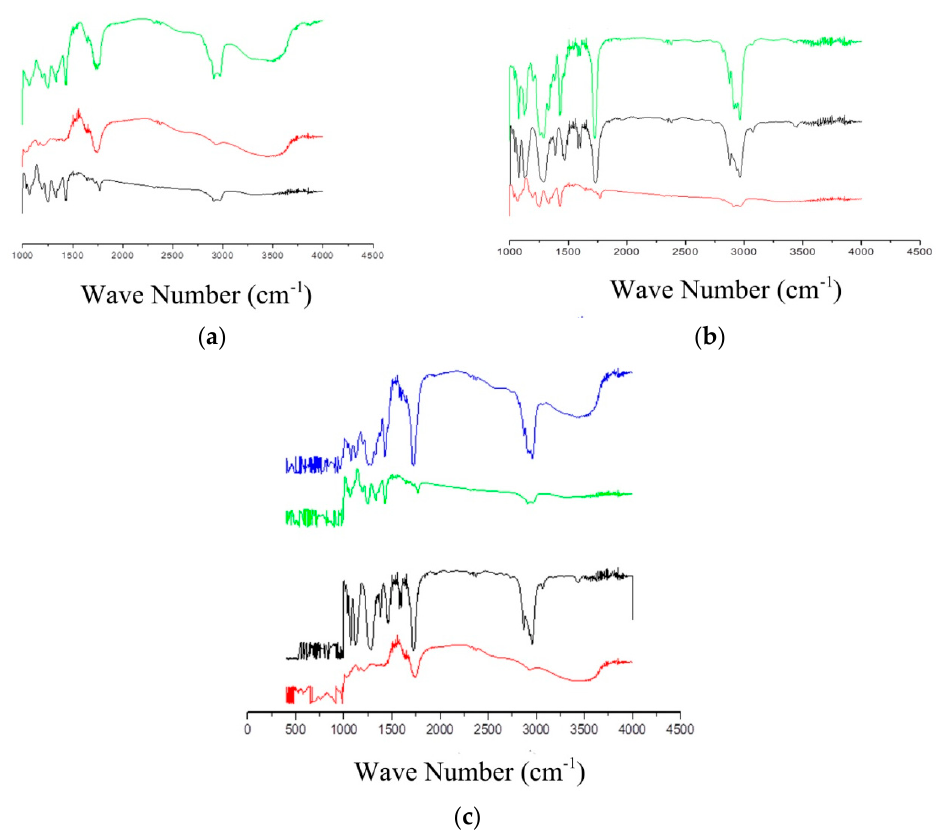
Figure 5. FT-IR spectra of different PIMs and their constituents. ( a ) PVC/poly( β -cyclodextrin) membrane (green), PVC (black) and poly( β -cyclodextrin) (red). ( b ) PVC/DBP membrane (green), PVC (red) and DBP (black). ( c ) PVC/DBT/poly( β -cyclodextrin) membrane (blue), PVC (green), DBP (black) and poly( β -cyclodextrin) (red). Each measurement was made in triplicate.